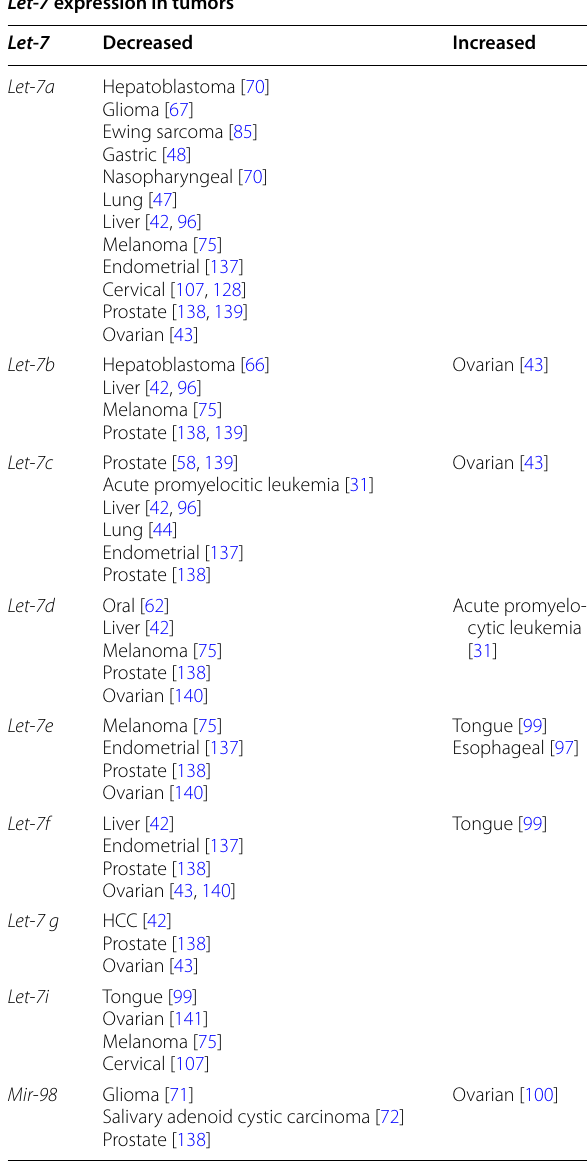
Table 2 Levels of let ‑ 7 family members relative to normal tissue in different types of human